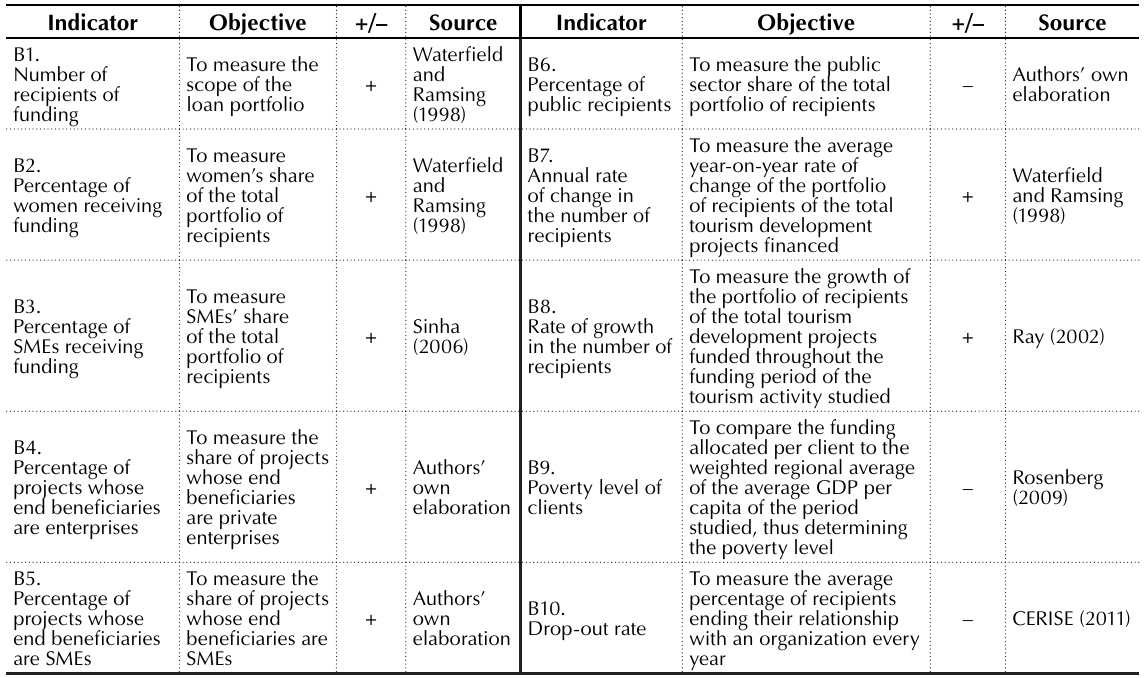
Source: Authors’ own